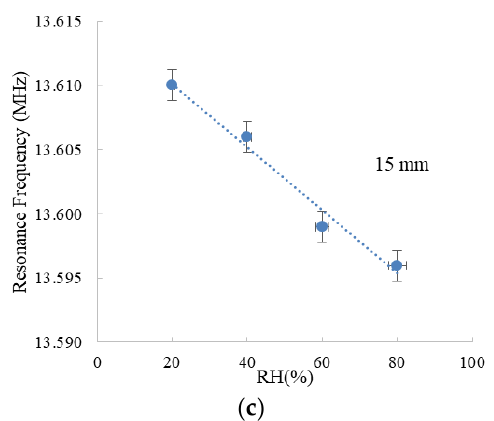
Figure 4. Resonance frequency of the reader while coupling the wireless sensor vs. RH level at 30 °C at a distance of ( a ) 5 mm; ( b ) 10 mm; ( c ) 15 mm. Error bars are calculated as the standard deviation of three measurement cycles of two different sensor tags.